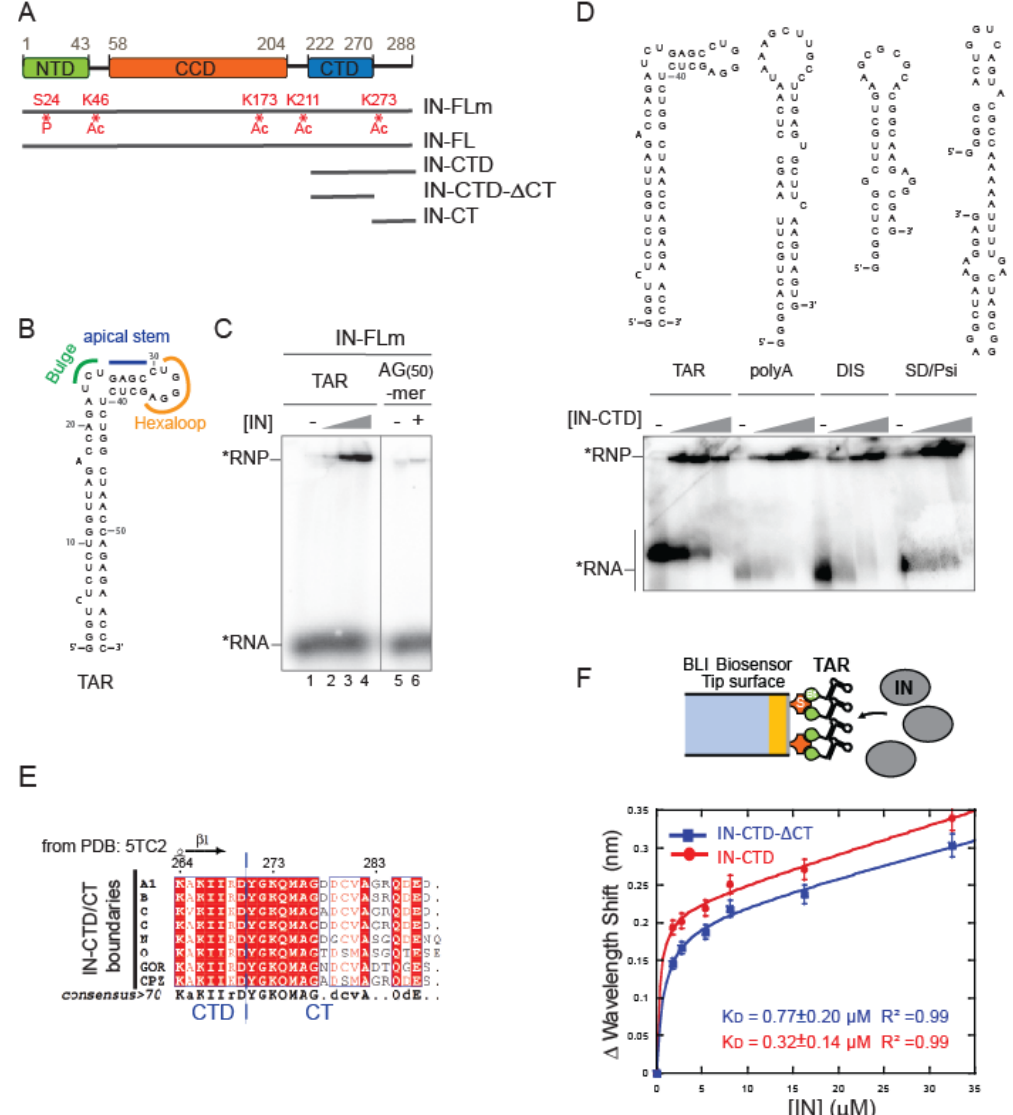
Figure 1. IN binds to structured RNA. ( A ) Schematic diagram showing the domain organization of IN: the N-terminal domain (NTD), the catalytic core domain (CCD) and the C-terminal domain (CTD) are indicated respectively in green, orange and blue rectangles. Recombinant protein versions used in this study are represented by grey lines: IN full-length from mammalian expression system (IN-FLm); IN full-length from E. coli (IN-FL); IN-CTD (residues 222 to 288); IN-CTD- Δ CT (222 to 270); IN-CT (270 to 288). Sites of phosphorylation (P) and acetylation (Ac) are shown in red. ( B ) Structural model of TAR RNA obtained with RNA Fold WebServer [48,49] predicting a minimum free energy of − 29.60 kcal/mol. ( C ) Representative native 6% polyacrylamide gel illustrating the Electrophoretic mobility shift assay (EMSA) showing the interaction of IN-FLm with TAR RNA or an unstructured RNA 50-mer (AG(50)-mer) labelled with 32P (black star). The RNA substrates (50 nM) were incubated with various concentrations of IN-FLm or without protein (TAR RNA: 0; 100, 200, 400 nM of IN-FLm; AG(50)-mer RNA: 0 or 400 nM of IN-FLm). ( D ) Models of secondary struc- tures of four RNA elements belonging to 5′ untranslated region of the HIV-1 RNA genome: TAR, Poly-A, DIS and SD/Psi (upper panel). EMSA assay showing the binding of IN-CTD to these RNA elements (lower panel). Increasing amounts of IN-CTD (0; 100; 200; 400 nM) were incubated with